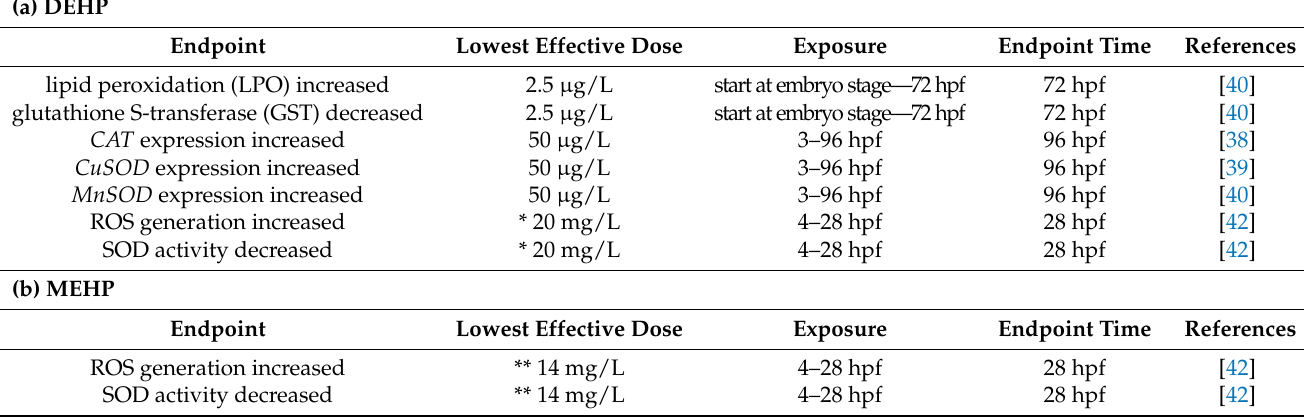
Table 7. Induction of oxidative stress from acute exposures to (a) DEHP and (b) MEHP on zebrafish embryos. * The concentration was converted from nM or µ M using the molar mass of DEHP 390.57 g/mol. ** The concentration was converted from nM or µ M using the molar mass of MEHP 278.34